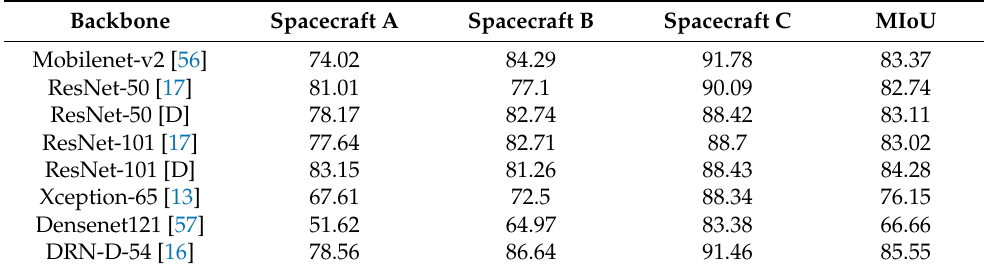
Table 5. The MIoU results of backbone comparative experiments on the test set.